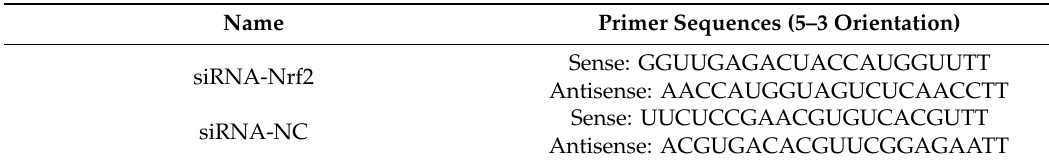
Table 2. Primer sequences of Nrf2